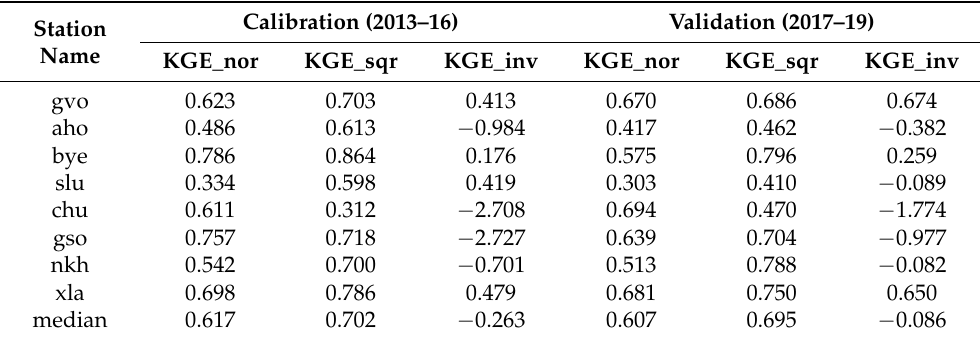
Table 4. Statistical metrics for calibration and validation period with deterministic SWAT model. KGE nor , KGE sqr , and KGE inv indicate performances with Q nor (more weight on high flow), Q sqr (more weight on average flow), and Q inv (more weight on low flow),